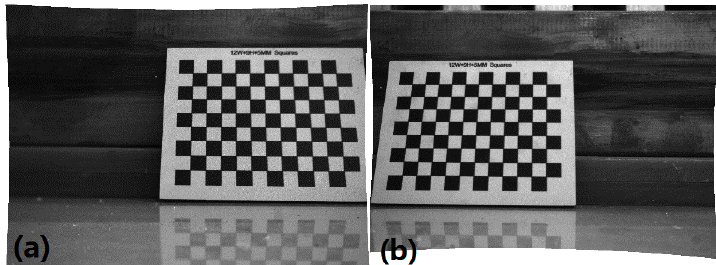
Figure 11. Images after calibration. (a) Figure 10L1 after calibration. (b) Figure 10R1 after